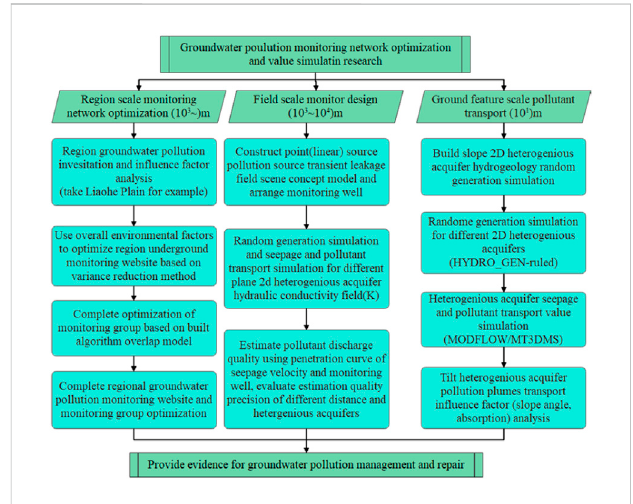
FIGURE 4 Groundwater pollution diffusion path based on multi-source data